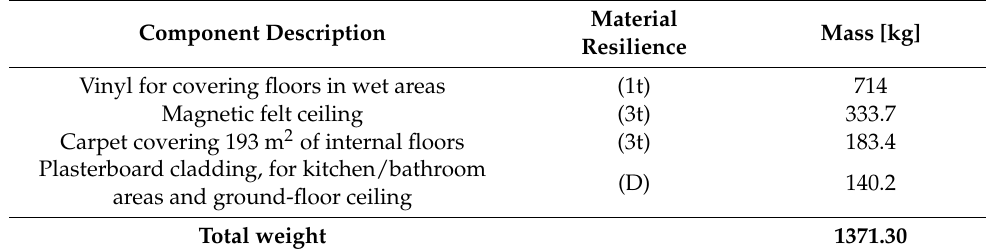
Table 3. Cladding and floor covering materials used in the L3 case study by mass (kg) and